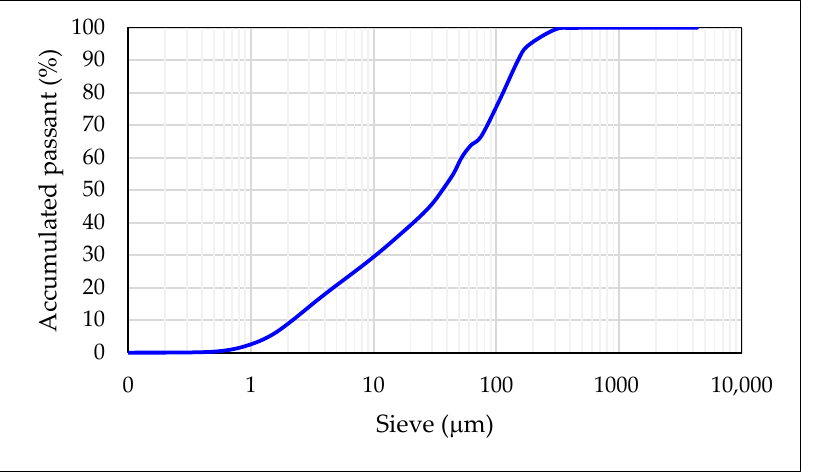
Figure 4. Tailings particle size curve used.